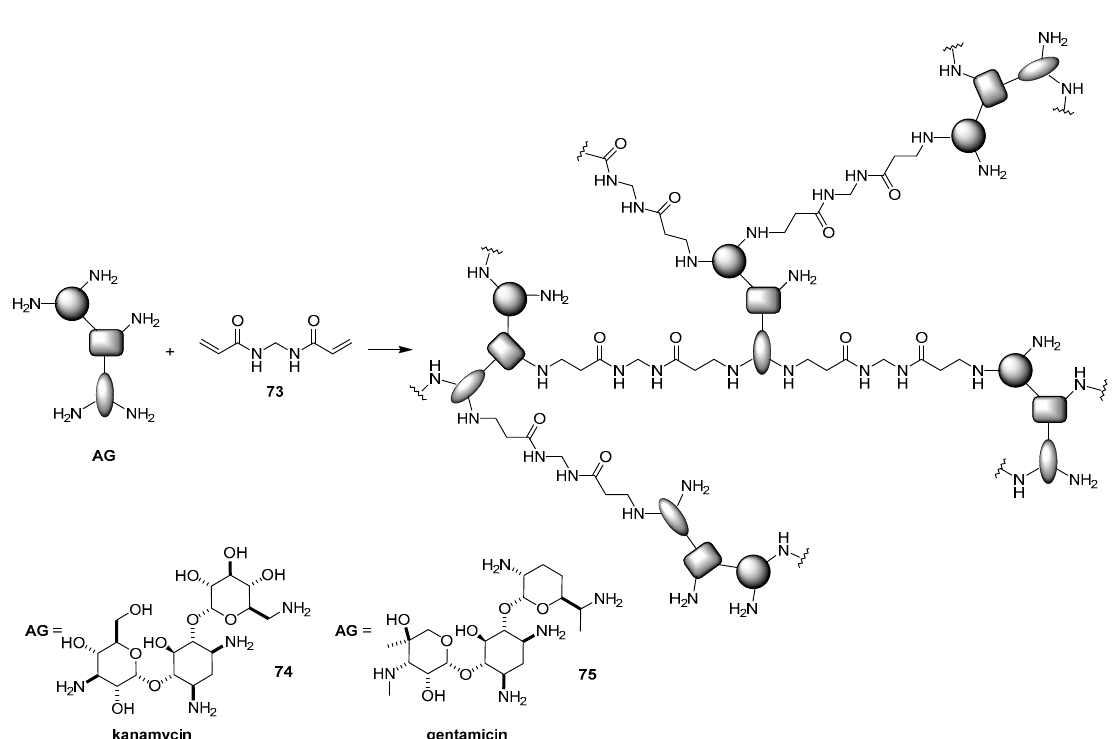
Figure 21. Synthesis of kanamycin- and gentamicin-based hyperbranched polymers 74 – 75 .